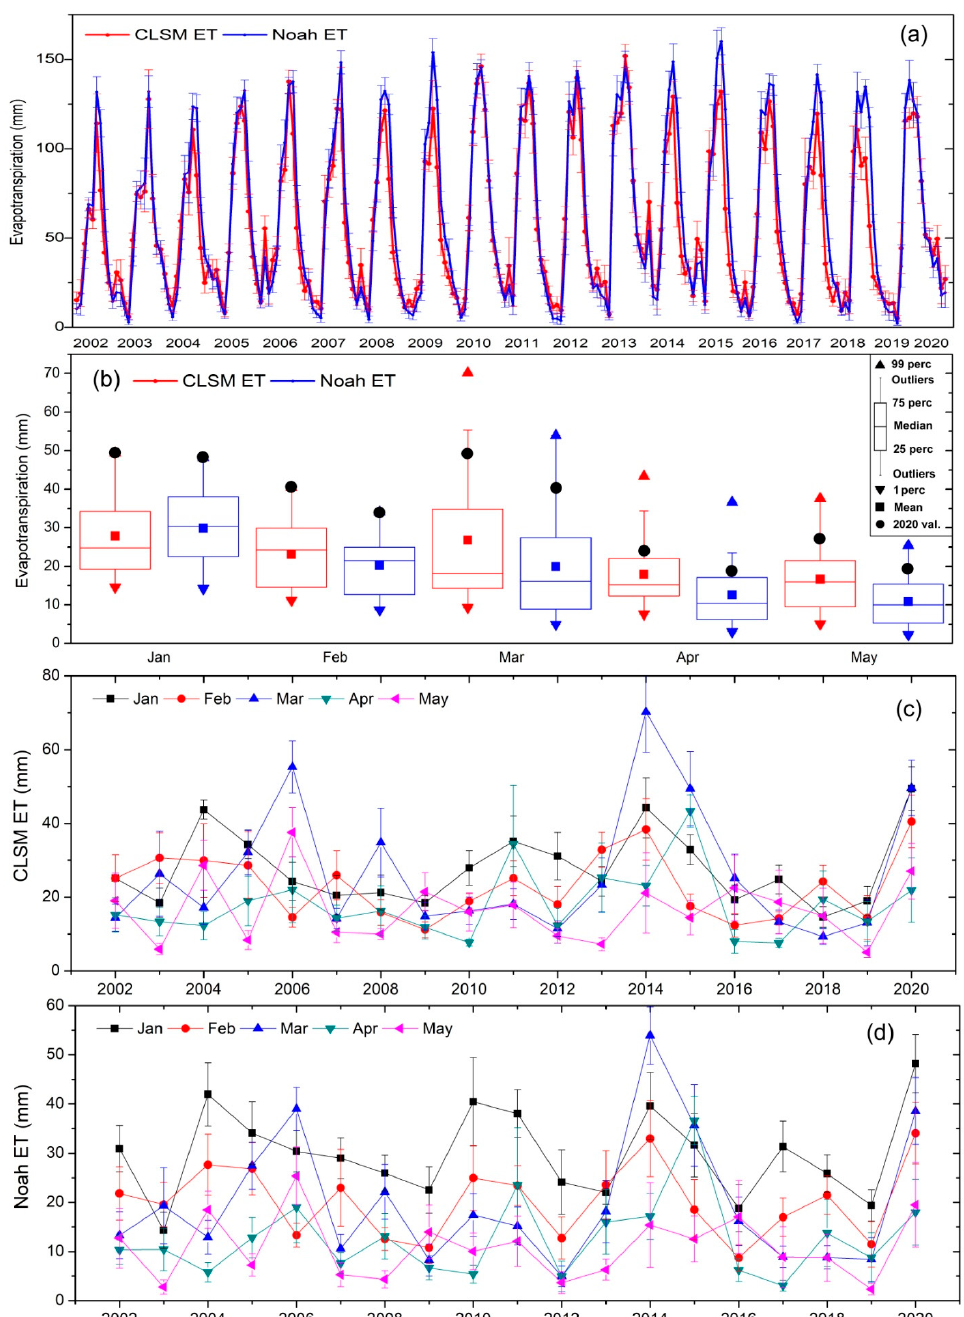
Figure 6. ( a ) Monthly mean evapotranspiration (ET) from the two land surface models, CLSM and Noah simulation in 2002–2020. ( b ) Box plot of monthly ET data between January and May. Box, whisker and symbols represent the statistics shown in the inset. Monthly values of ( c ) CLSM ET and ( d ) Noah ET.